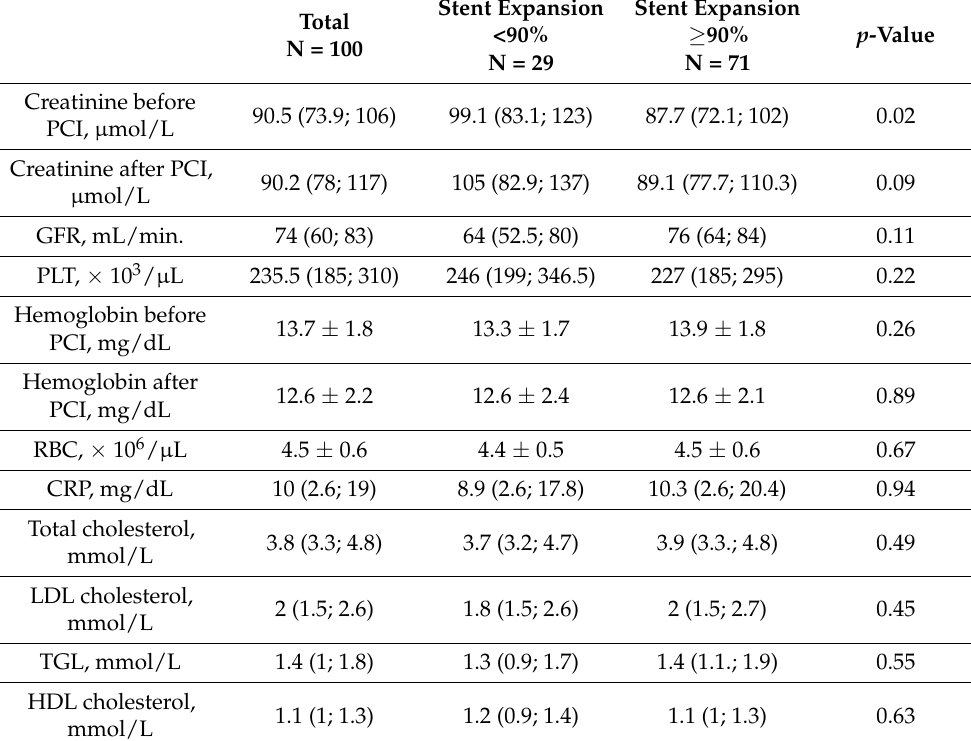
Table 2. Biochemical